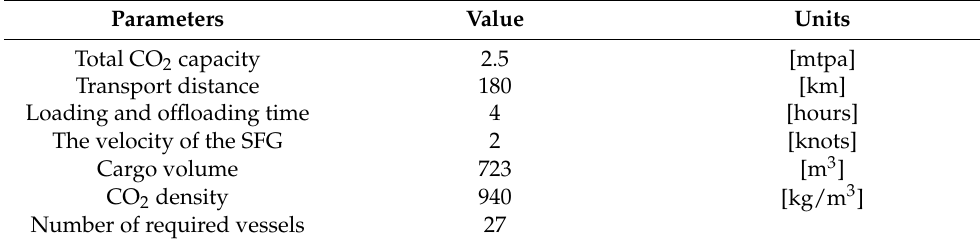
Table 11. Required number of SFG vessels (baseline design).